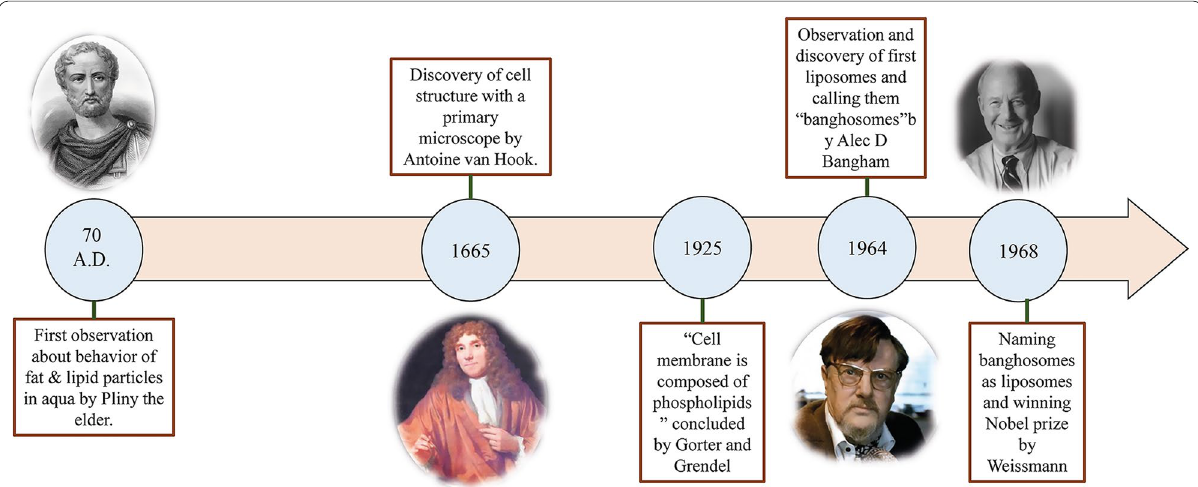
Fig. 1 Diagram of observations that led to the discovery of liposomes. The historical and scientific trends of studying behaviors of lipid and fat particles in water and the observations leading to the liposomes discovery, along with images of the scientists involved in the event, Pliny the Elder [23], Anthonie Van Hook [24], Alec D. Bangham [25], and Gerald Weissmann [26], respectively, from left to